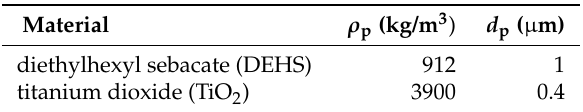
Table 1. Material, density ρ p and diameter d p of two typical seeding particles.